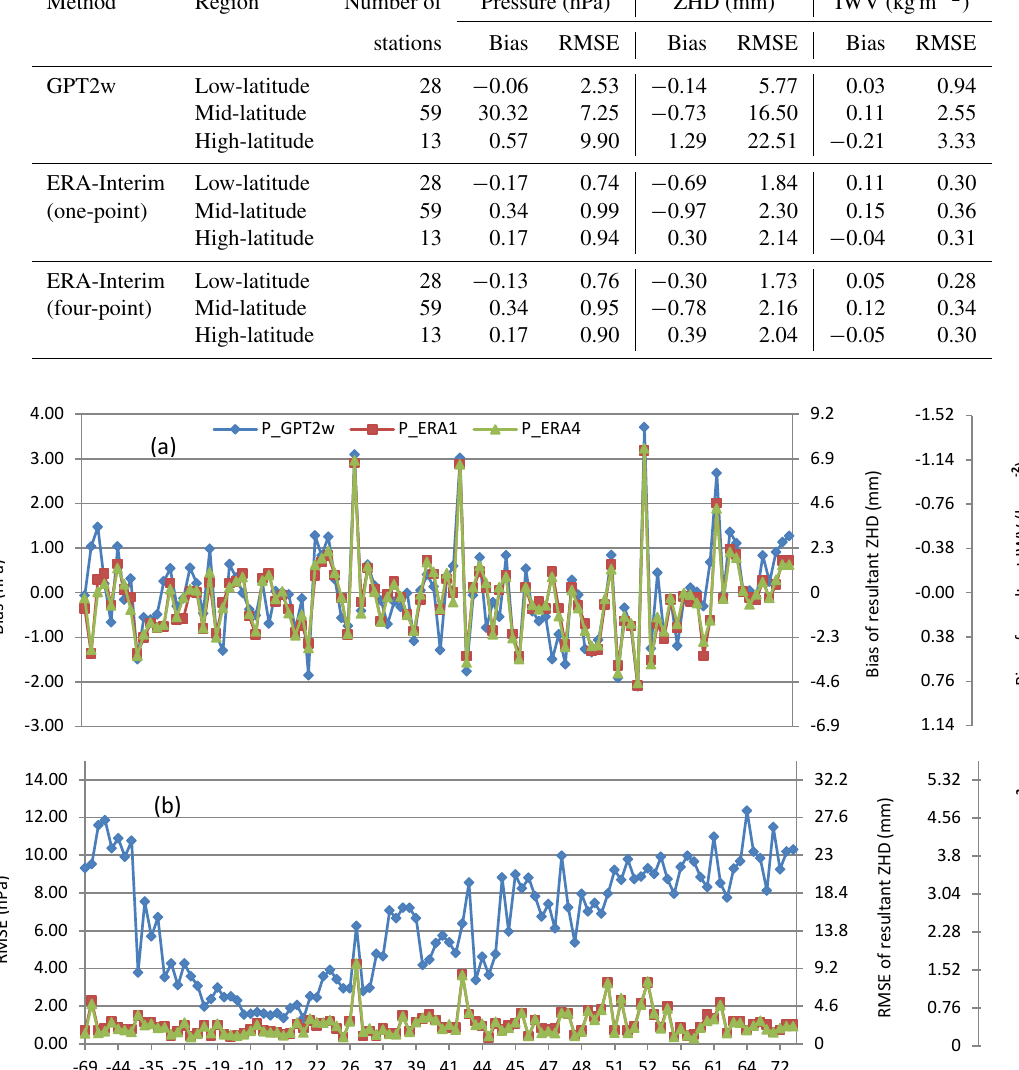
Table 1. Mean values of the biases and RMSEs of 6h pressure, ZHD and IWV derived from GPT2w and ERA-Interim for the 100 stations in low- ( − 30 to 30 ◦ ), mid- (30 to 60 ◦ and − 30 to − 60 ◦ ) and high-latitude (60 to 90 and − 60 to − 90 ◦ ) regions for the period 2000–2013.